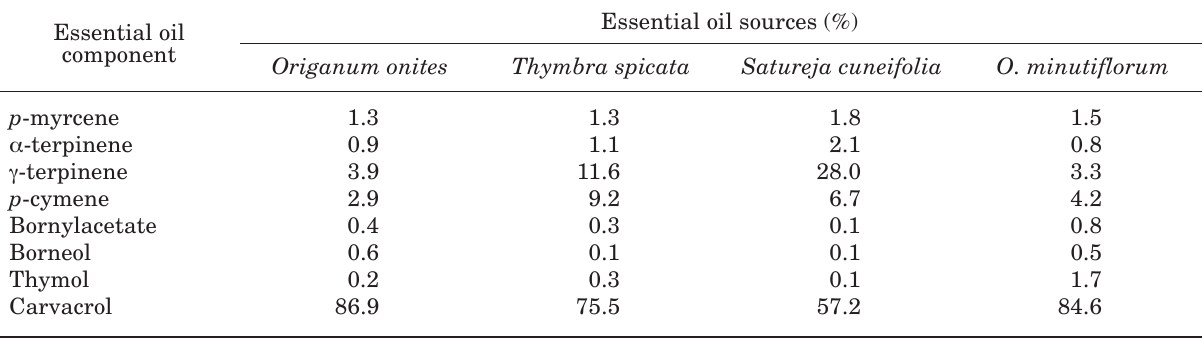
Table 1. Chemical composition of the essential oils (% total peak area) of Origanum onites, Thymbra spicata, Sature- ja cuneifolia and O.